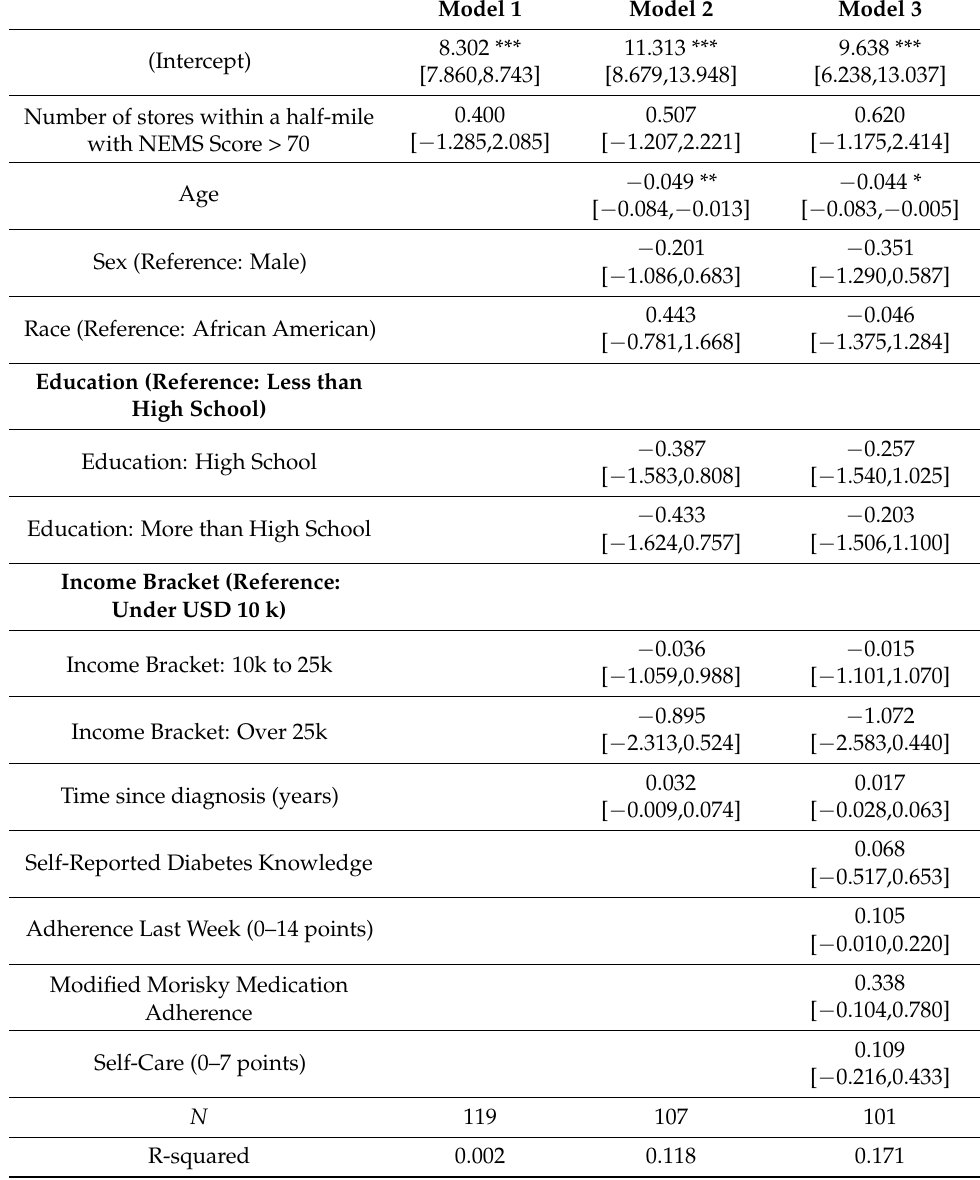
Table 3. Regression